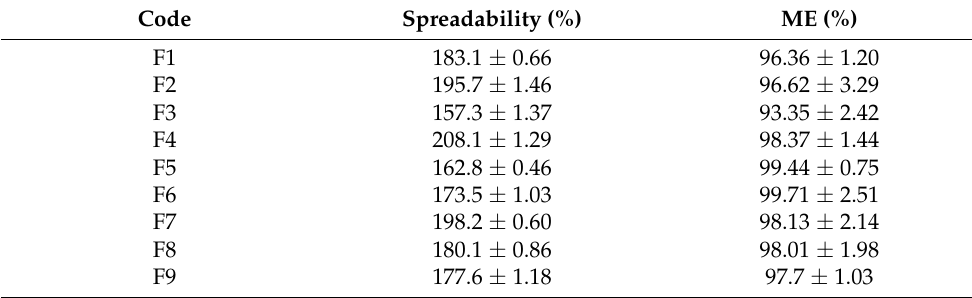
Table 1. Physicochemical characterization of smart mucoadhesive buccal gels.